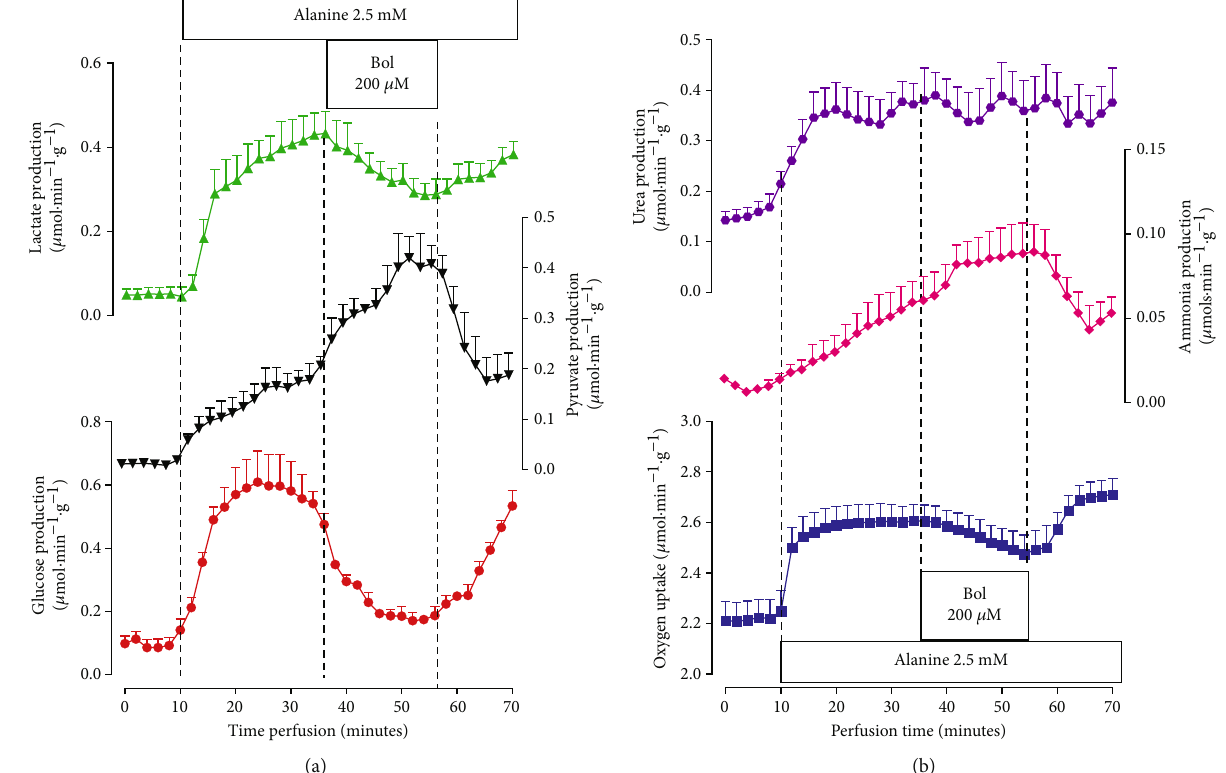
Figure 5: Time course of the e ff ects of boldine on the alanine gluconeogenesis in the perfused livers isolated from fasted rats. Livers were perfused as described in the Materials and Methods. Boxes near to the time scale indicate the alanine and boldine infusion periods and concentrations. The out fl owing perfusate was sampled every 2 minutes and used to quantify glucose, pyruvate, lactate, ammonia, and urea. Oxygen uptake was monitored polarographically by a platinum electrode. Data are the means ± mean standard errors of 4 to 5 liver perfusion